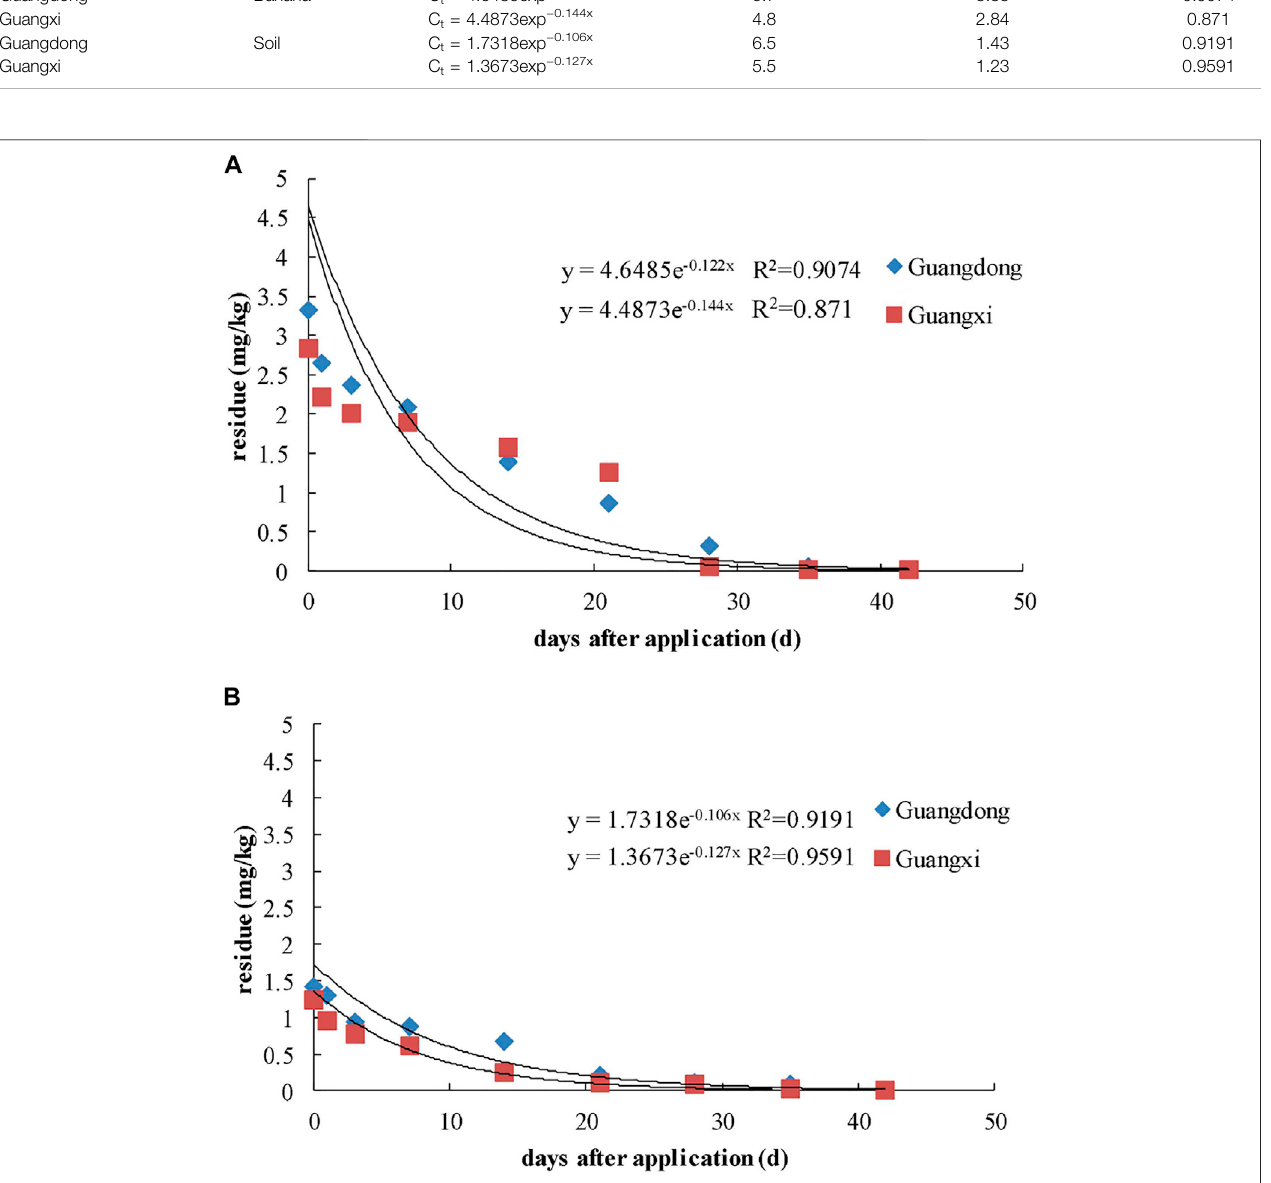
FIGURE 3 | Dissipation curve of kresoxim-methyl in banana (A) and soil (B) .